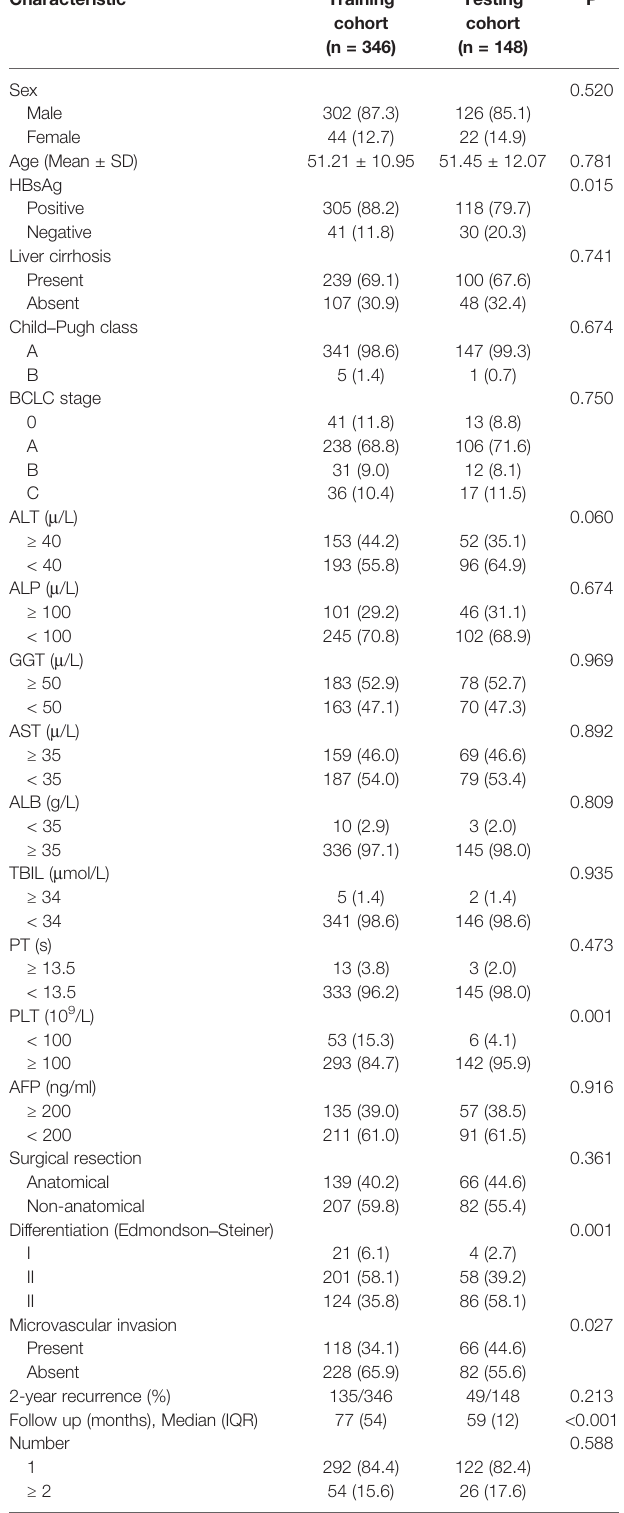
TABLE 1 | Baseline characteristics of hepatocellular carcinoma